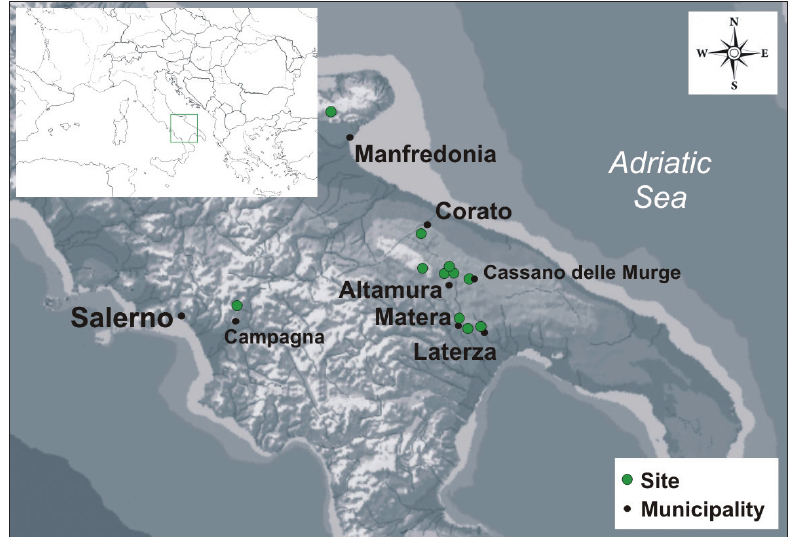
Figure 4. Geographic range and distribution map of Euphorbia nicaeensis subsp. japygica . Habitat and ecology. Euphorbia nicaeensis subsp. japygica grows typically on arid grassland and garrigues, up to about 1,000 m a.s.l. From a phytosociological point of view it is a characteristic species of the Acino suaveolentis-Stipetum austroitalicae